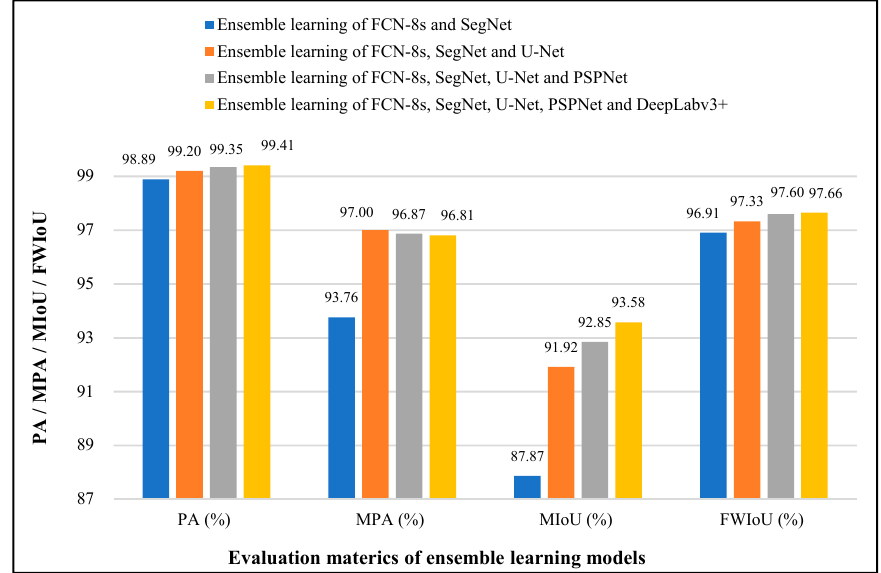
Figure 8. The testing performance of four ensemble learning models.